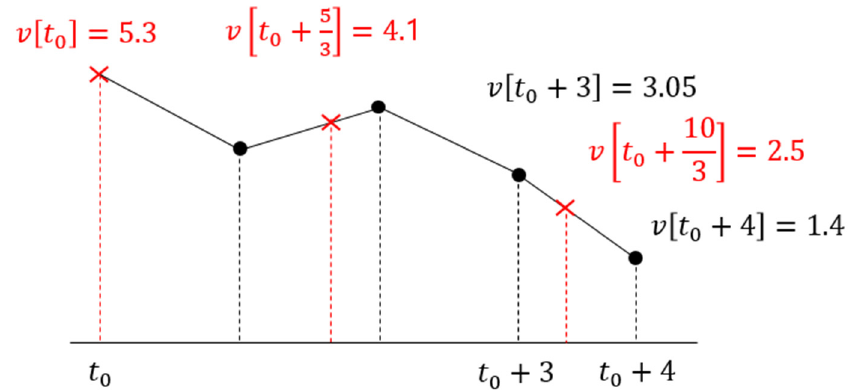
Figure 5. Method of calculating replacement frames. The red cross indicates replacement frame values and the black bullet indicates original frame values when s = 6